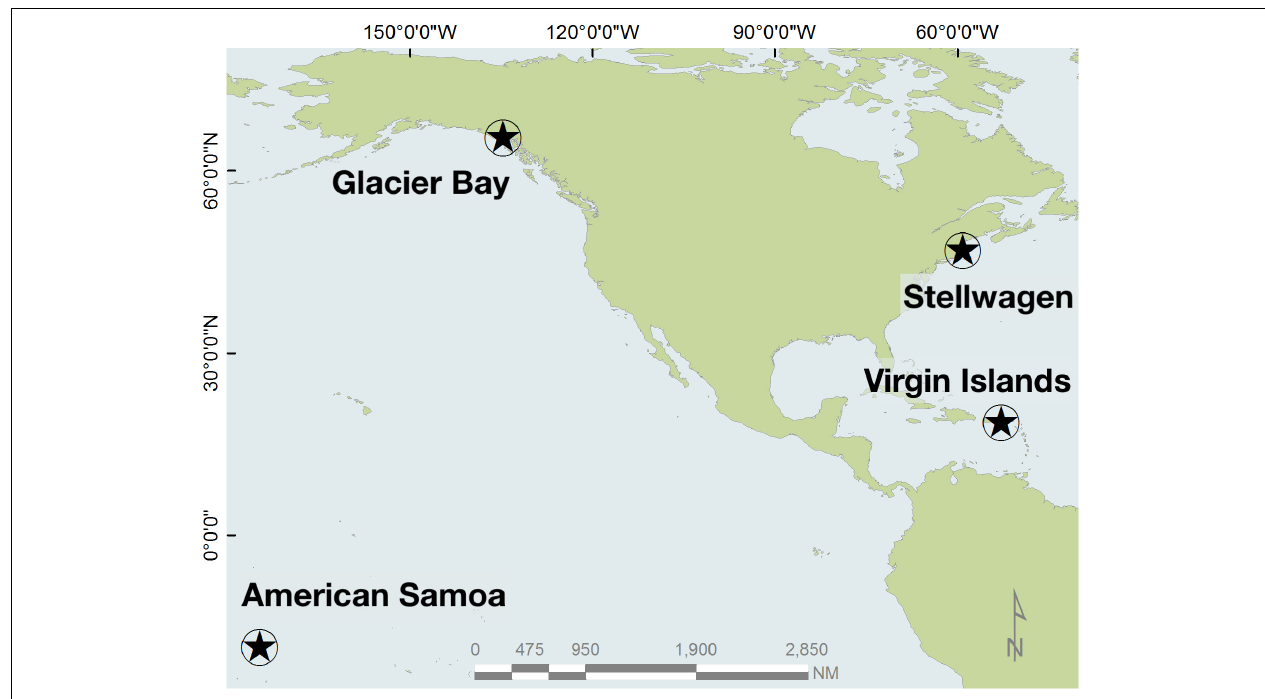
FIGURE 1 | Map of recording sites: the National Park of American Samoa (American Samoa), the Glacier Bay National Park (Glacier Bay), the Stellwagen Bank National Marine Sanctuary (Stellwagen), and the Buck Island Reef National Monument (Virgin Islands).